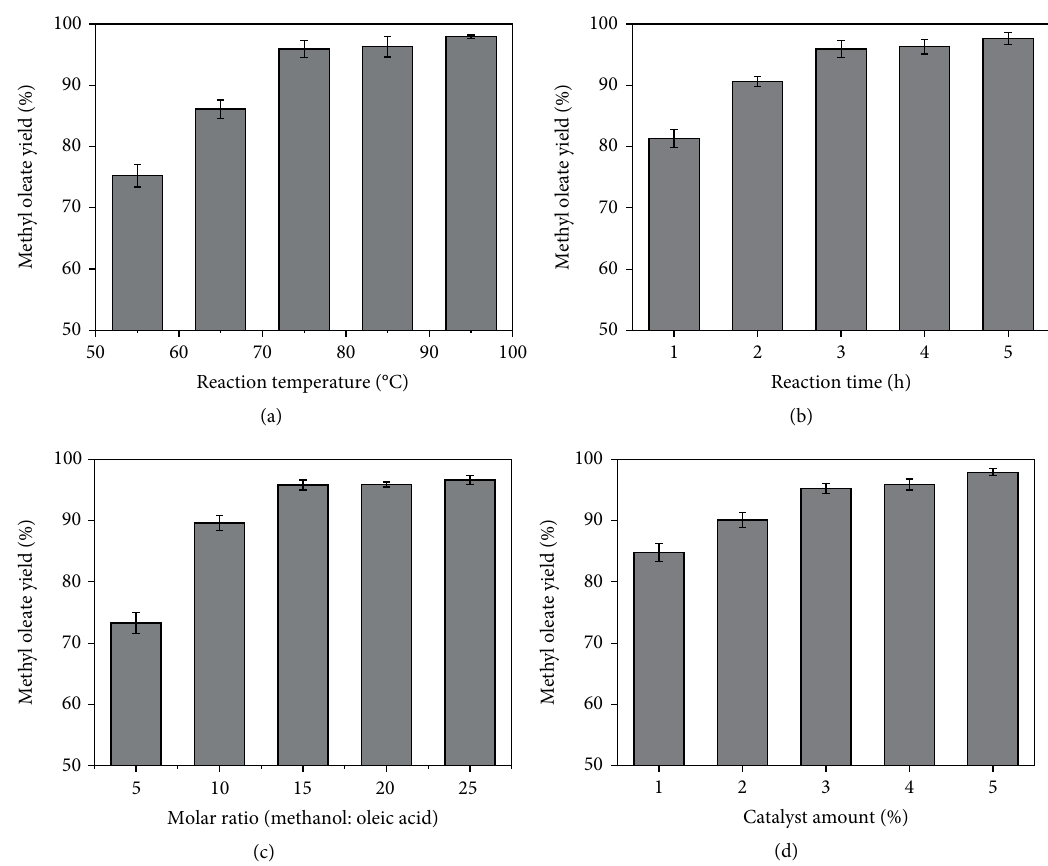
Figure 4: Performance optimization of oleic acid (AV = 184.52 mg KOH/g) with the CS-SO time, (c) methanol/oleic acid molar ratio, and (d) catalyst amount.